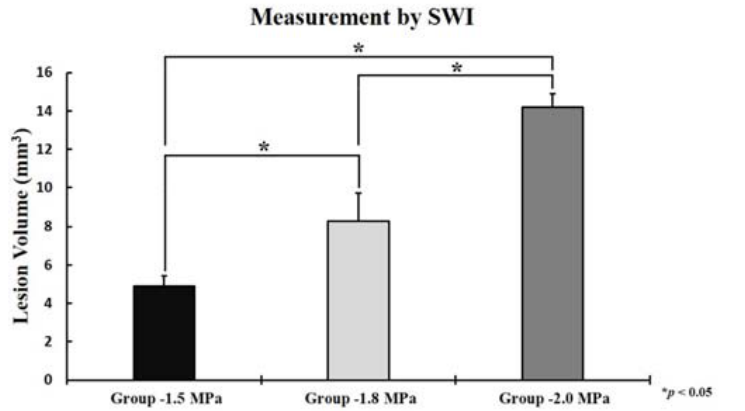
Figure 4. The volume of petechial hemorrhage measured by susceptibility weighted imaging(SWI), 1.5 MPa: 4.91 ± 0.53 mm 3 , 1.8 Mpa: 8.28 ± 1.43 mm 3 , and 2.0 MPa: 14.21 ± 0.70 mm 3 . The data represented were the mean ± SD ( n = 3). Statistical significance: * p ≤ 0.05 significant.